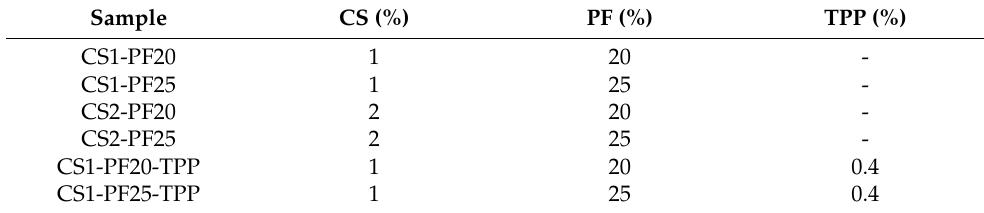
Table 1. Composition and nomenclature of the hydrogels.